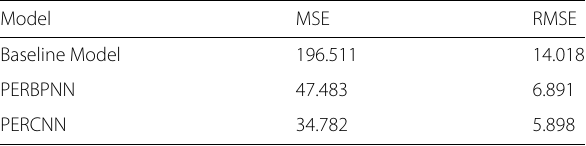
Table 4 Errors performed by different models